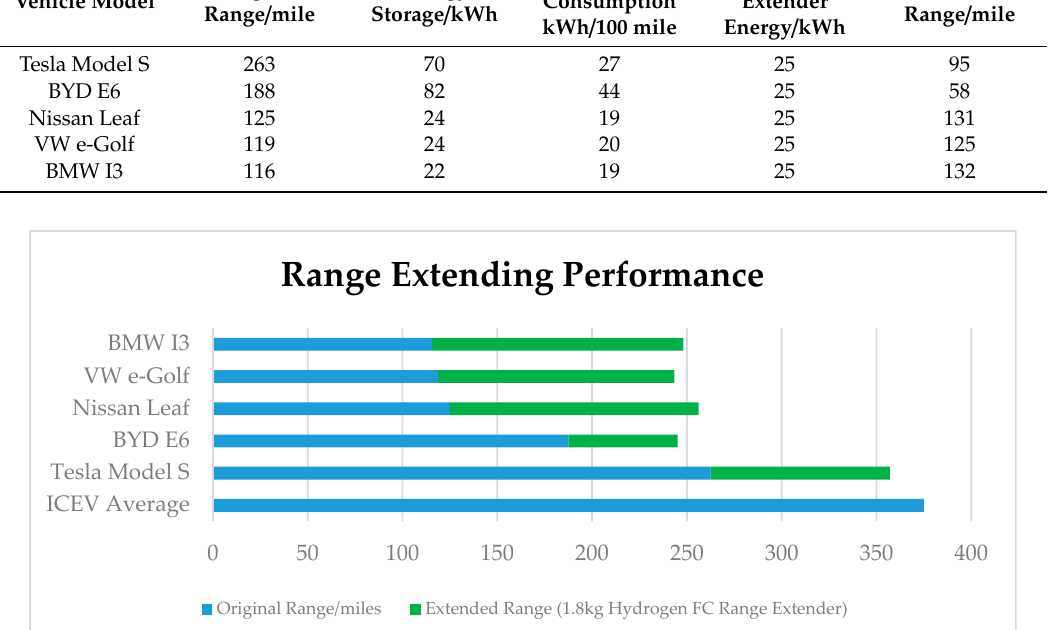
Figure 5. Range extending performance for the BEV.